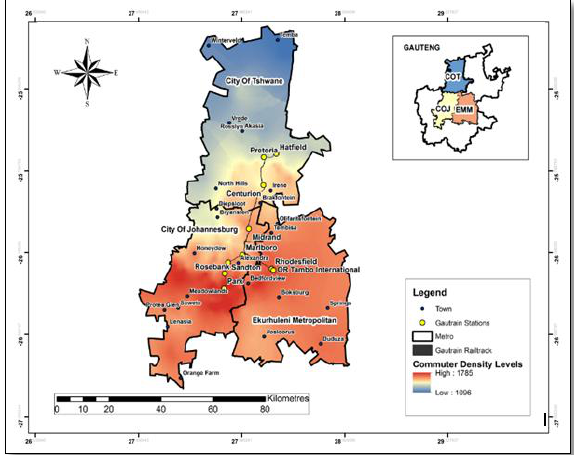
Figure 5: Maps showing the concentration levels of the tweets made in the Gauteng